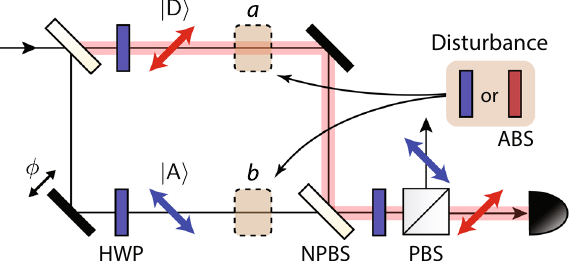
Fig. 1 Essential schematic based on the Mach-Zehnder inter- ferometer. A polarized beam is split into two paths with a non- polarizing beam splitter (NPBS). With half-wave plates (HWP), the polarizations in the upper and lower paths, respectively, are set at D j i and A j i . The polarizing beam splitter (PBS) ensures that only the D j i polarization reaches the detector. To probe the locations of the photon itself and its polarization state, an absorber (ABS) or an HWP is inserted in paths a or b